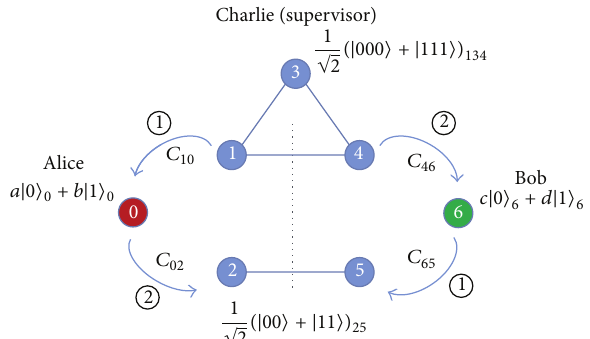
Figure 4: The scenario of our proposed